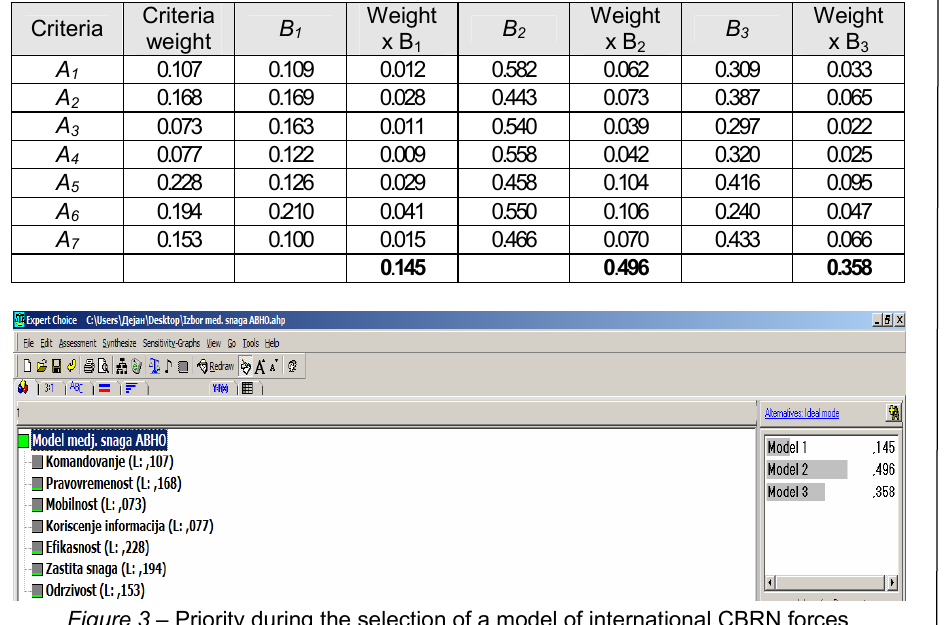
Figure 3 – Priority during the selection of a model of international CBRN forces Рис . 3 – Приоритеты при выборе моделей международных войск РХБЗ Slika 3 – Prioritet prilikom izbora modela me đ unarodnih snaga